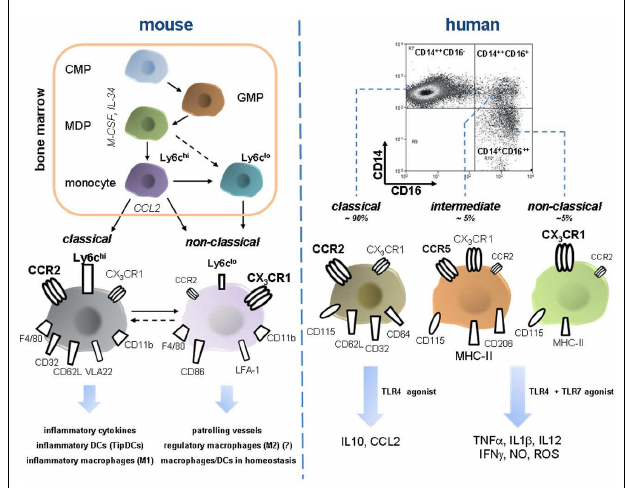
FIGURE 3 | Development and features of murine and human monocyte subsets. Monocyte development from a common myeloid progenitor (CMP) occurs in the bone-marrow under the control of M-CSF and IL-34 and increasing lineage commitment. A macrophage dendritic progenitor (MDP) gives rise to Ly6c hi monocytes and probably also to Ly6c lo monocytes. Bone-marrow egress is directed by CCR2, maybe also by other pathways such as CXCR4/CXCL12 (not depicted). Peripheral Ly6c hi can shuttle back to the bone-marrow and possibly transdifferentiate into Ly6c lo monocytes,